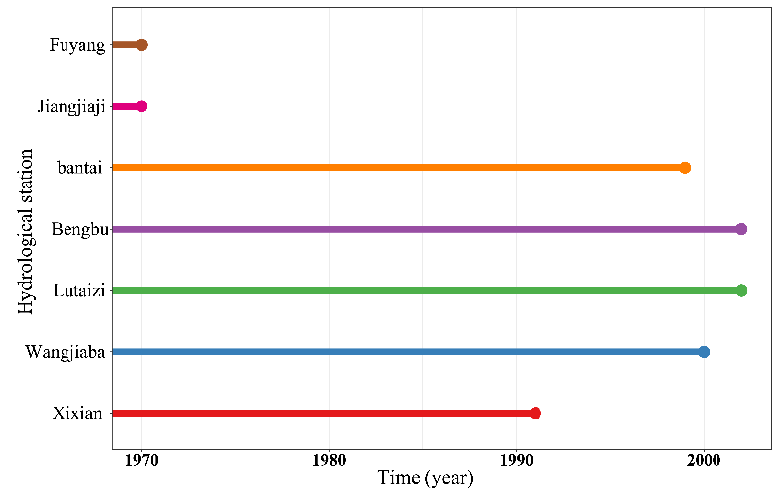
Figure 3. Results of Pettitt test in seven hydrological stations in HRB.